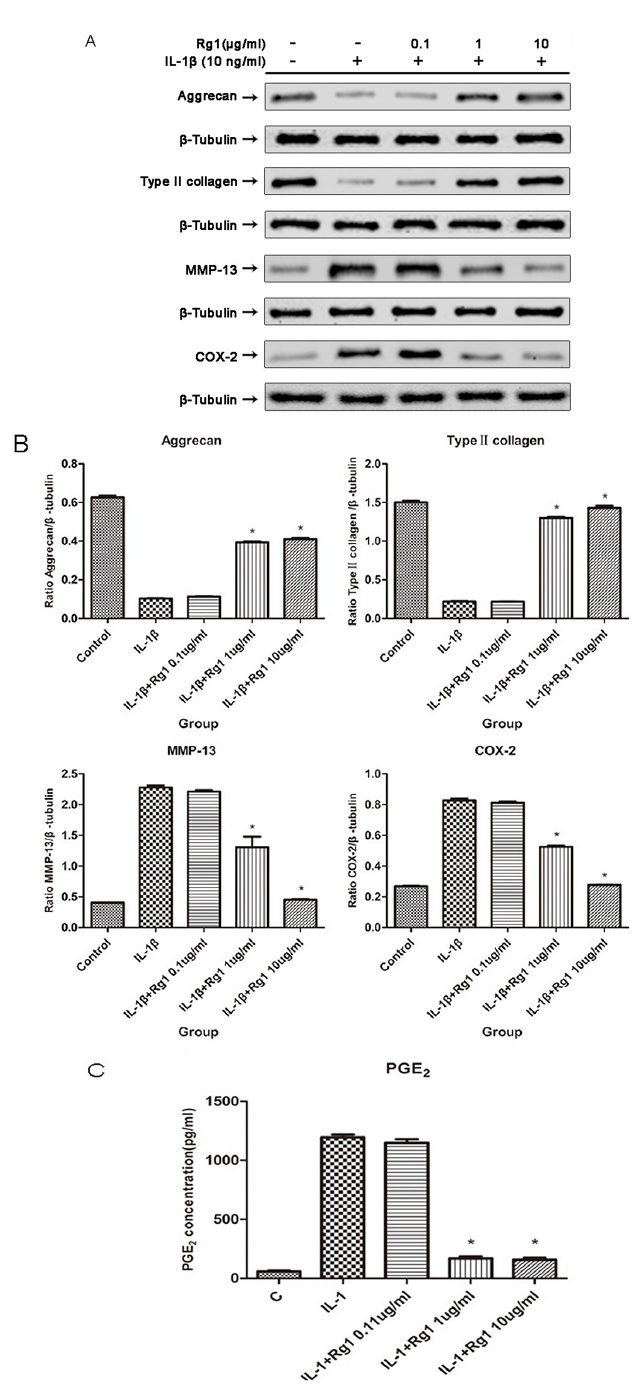
Figure 2. Effect of Rg1 on protein levels of extracellular matrix and inflammatory mediators after induction by IL-1 β . Human OA chondrocytes were treated with medium (control group), and IL-1 β (10 ng/mL) alone or in combination with Rg1 (0.1, 1, or 10 µ g/mL). Total protein was extracted for Western blot analysis. The following proteins were assessed: type II collagen, aggrecan, MMP-13, COX-2 and β -Tubulin ( A ); the relative protein levels of type II collagen, aggrecan, MMP-13 and COX-2 were quantified by densitometric analysis and normalized to β -tubulin ( B ); Prostaglandin E2 (PGE 2 ) concentrations in the corresponding culture media were measured by enzyme-linked immunosorbent assay (ELISA) ( C ). Data are mean ± SEM of four independent experiments. * p < 0.05 compared with cells treated with IL-1 β